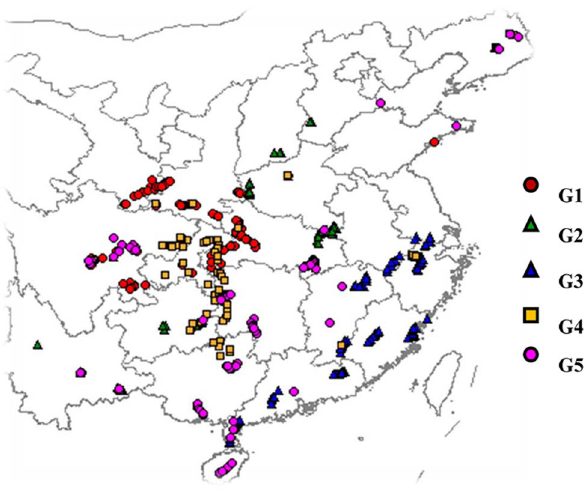
Figure 2. The original geographical distribution of 457 M. sinensis accessions showed on a partial Chinese map. The colorful objects represent various subpopulations generated by population structure analysis. The two accessions from USA are not shown in this figure.